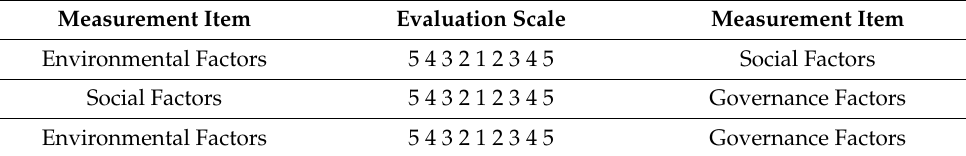
Table A4. Main criteria question items.